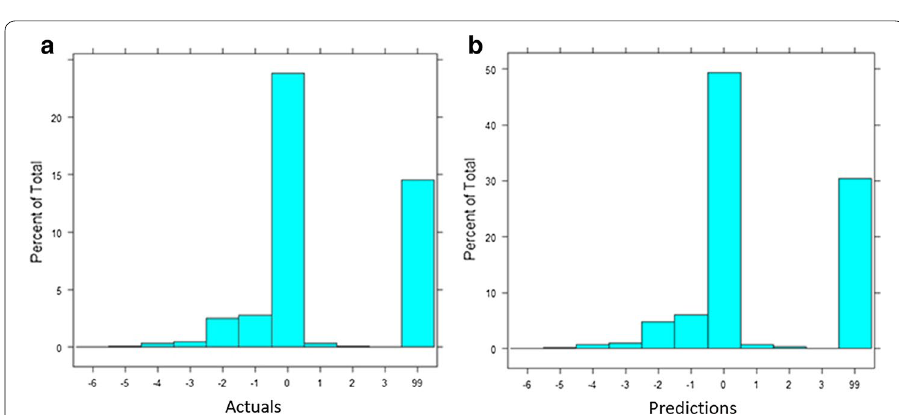
Fig. 12 a Actual and b imputed/predicted periodontitis columns’ distributions are very